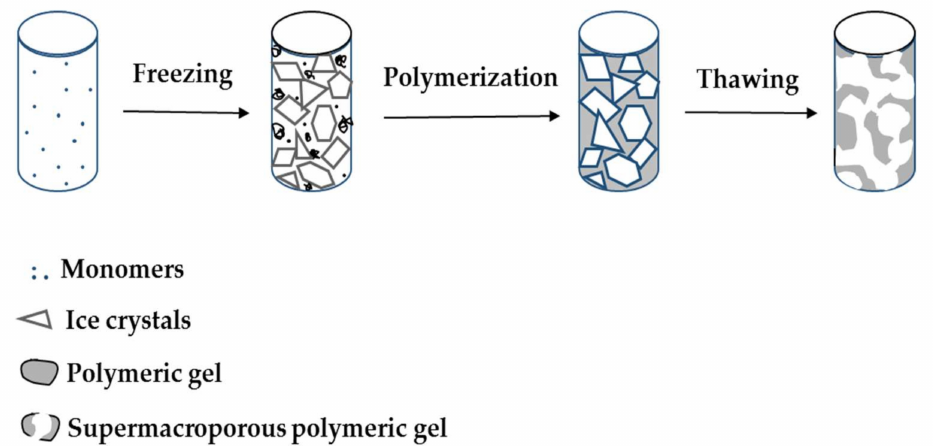
Figure 1. Illustration of supermacroporous cryogel preparation. Republished with permission from [23]. Copyright 2004